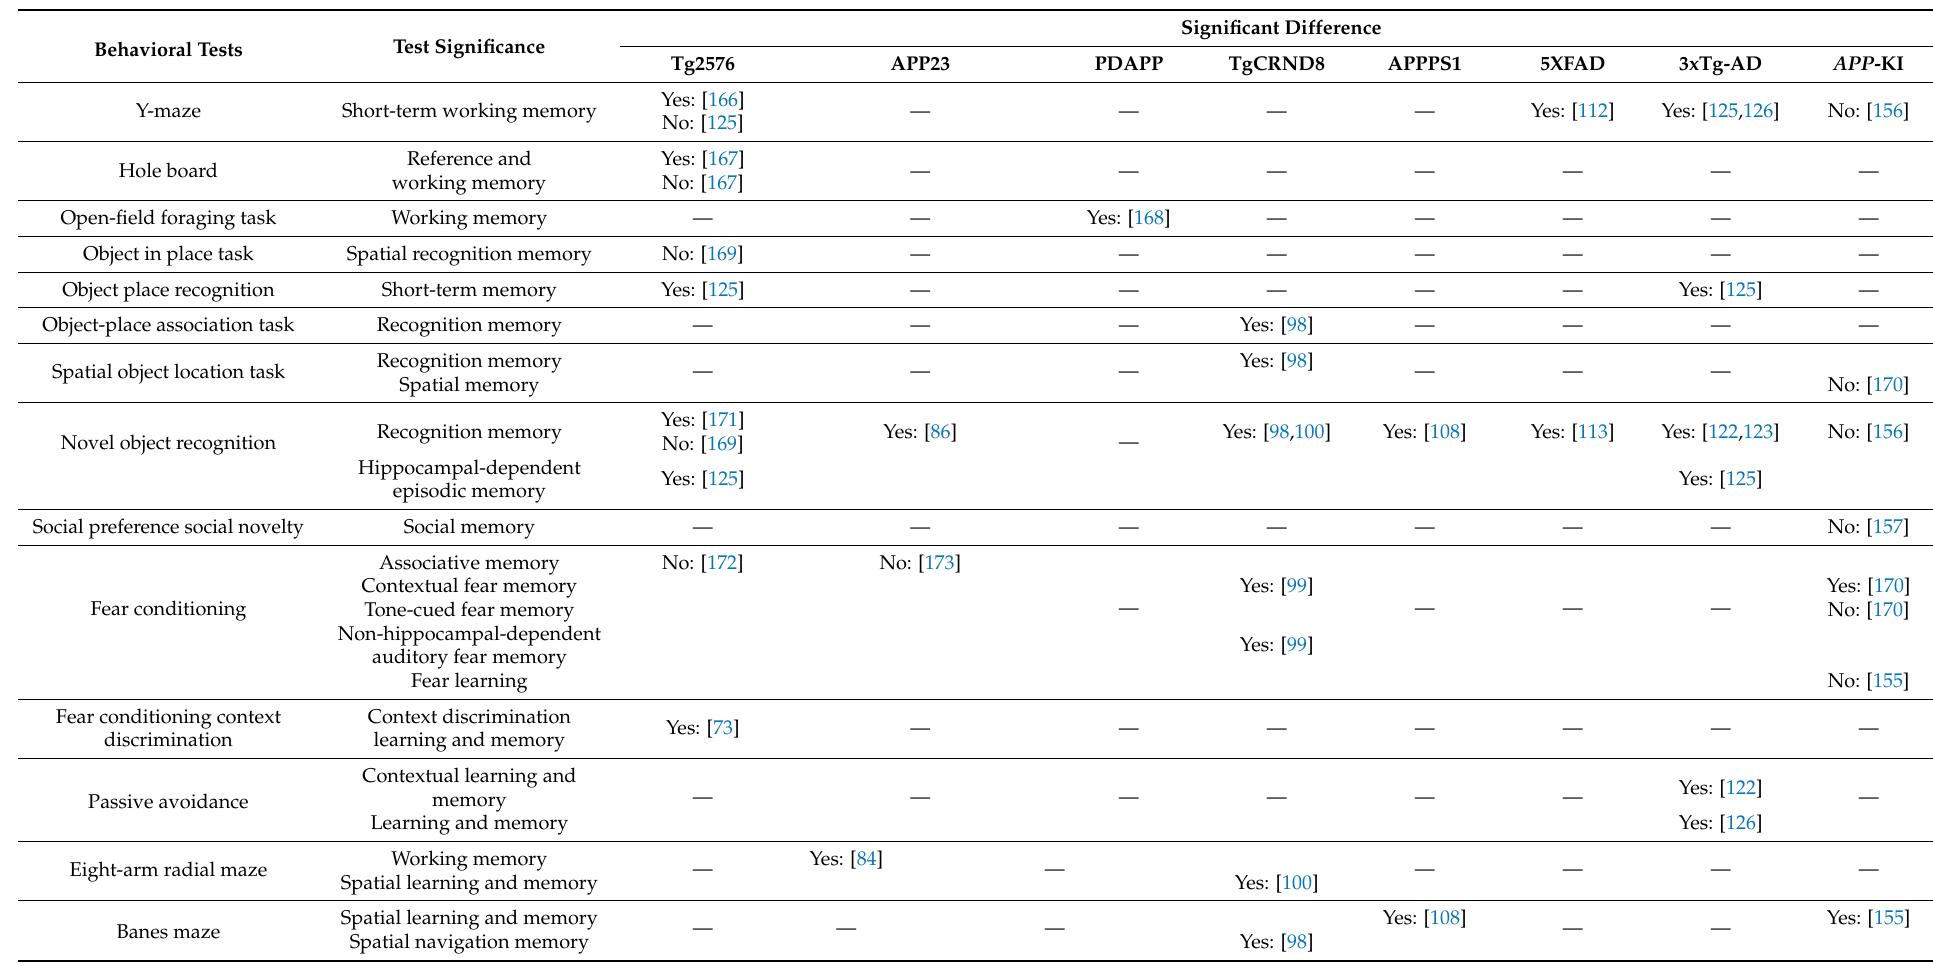
Table 3. Summary of reference with learning- and memory-associated behavioral tests in popular AD model mice over the past 5